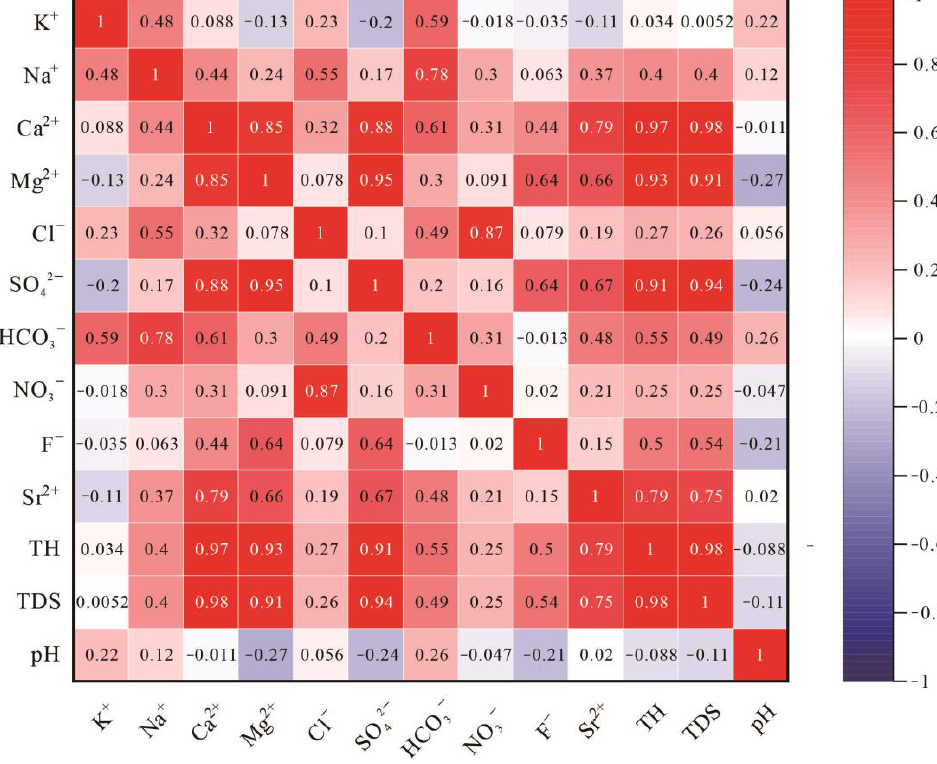
Figure 4. Pearson correlation coefficient matrix for each ion content of surface water and groundwater in the Lower reaches of Yarlung Zangbo River. Data are from Table 1.